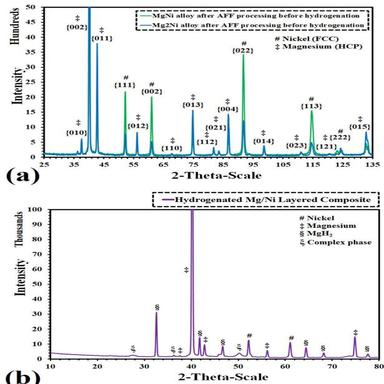
e (a) XRD analysis results for the MgNi and Mg2Ni layered composite materials after AFF manufacturing before hydrogenation measurements. (b) XRD pattern for the consolidated Mg/Ni layered composite material with higher magnesium content after hydrogenation experiment before de-hydrogenation testing, showing residue products' nature.